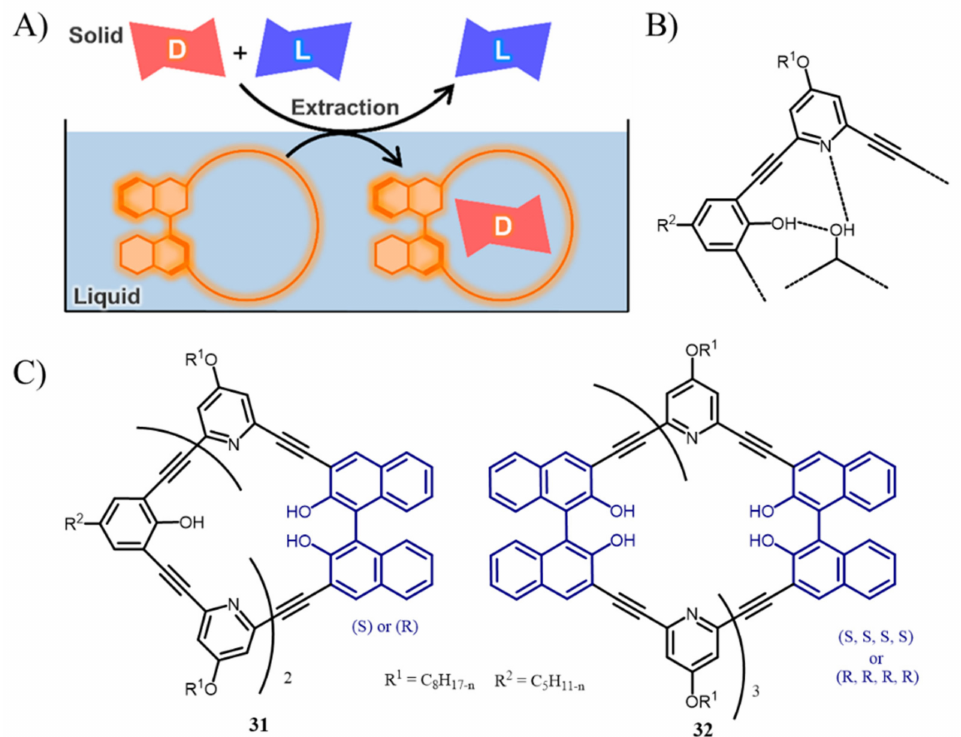
Figure 12. ( A ) Mechanism of chirality recognition of 31 and 32 for guests. Reprinted (adapted) with permission from Ref. [46] Copyright 2019 American Chemical Society. ( B ) The push − pull hydrogen bonding between guest and host. ( C ) Structure of BINOL–based macrocyclic receptors 31 and 32